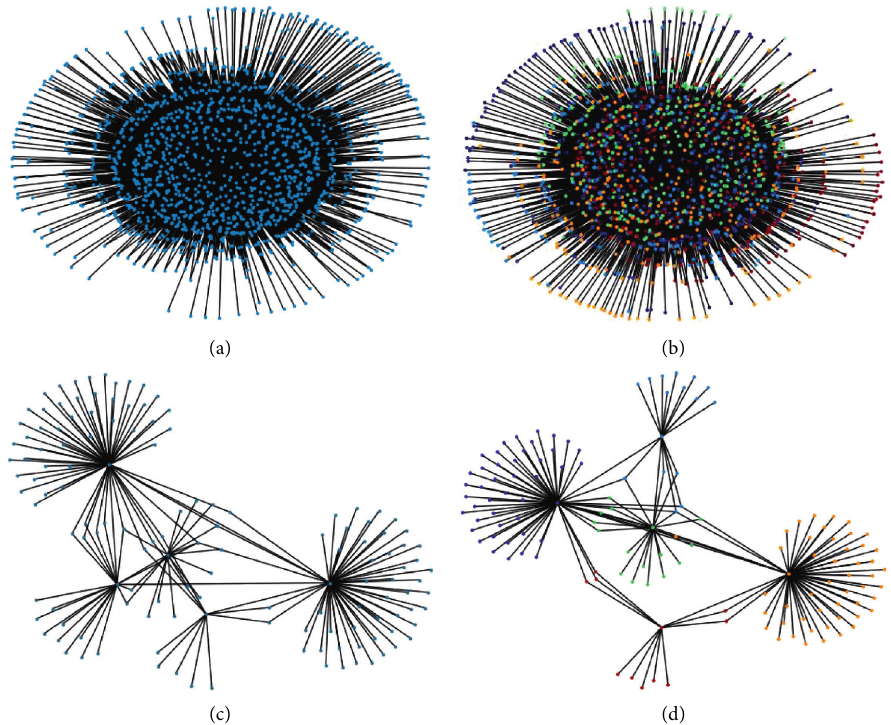
Figure 3: Analysis based on bipartite networks datasets using (a) original network using the Movie Lens 100K dataset; (b) community detection using the Movie Lens 100K dataset; (c) original network using the American Revolution dataset; (d) community detection using the American Revolution dataset.